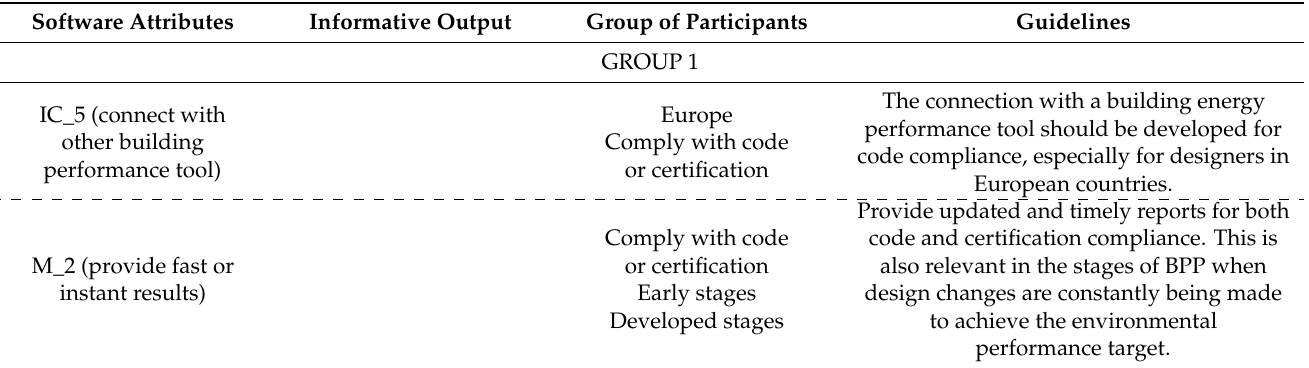
Table 9. Guidelines based on the groups of